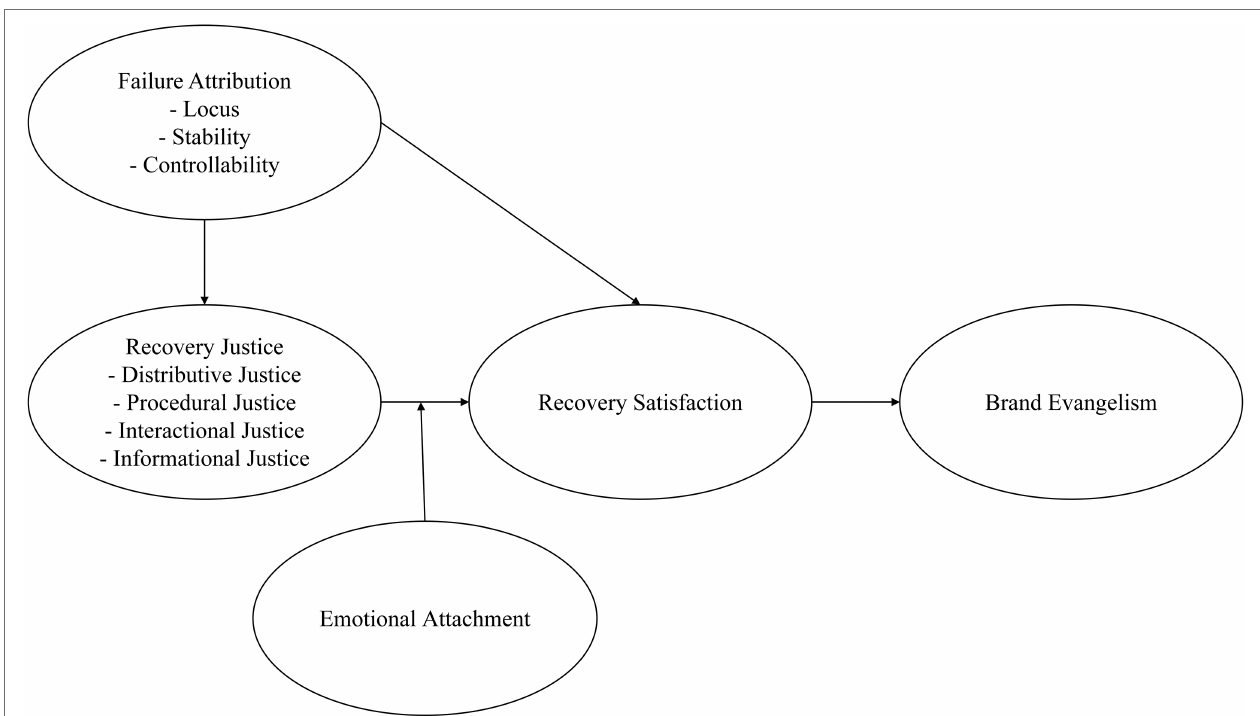
FIGURE 1 | Research model for understanding how failure attribution and recovery justice link to brand